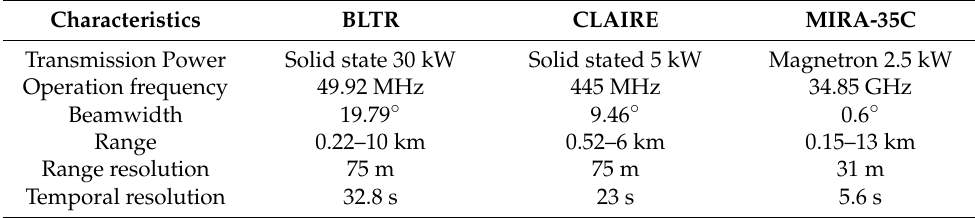
Table 1. Characteristics of BLTR, CLAIRE and MIRA-35C